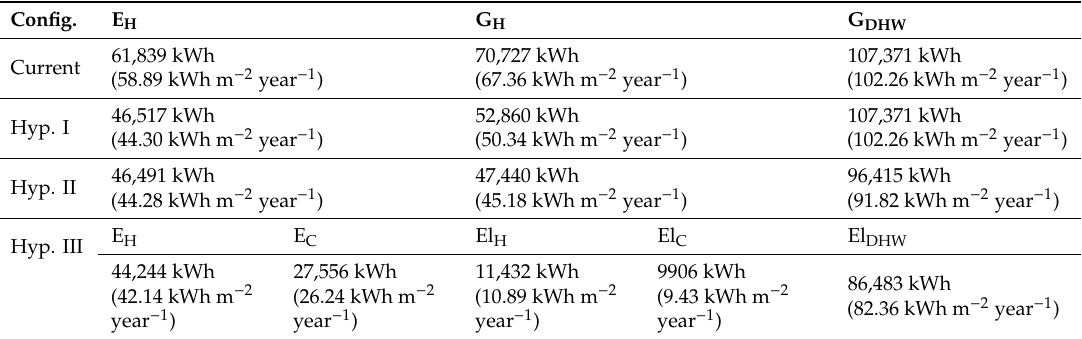
Table 1. Energy need for heating (EH) and cooling (EC) and consumption (gas G; electricity El) for Heating and Domestic Hot Water (DHW) in all the configurations.